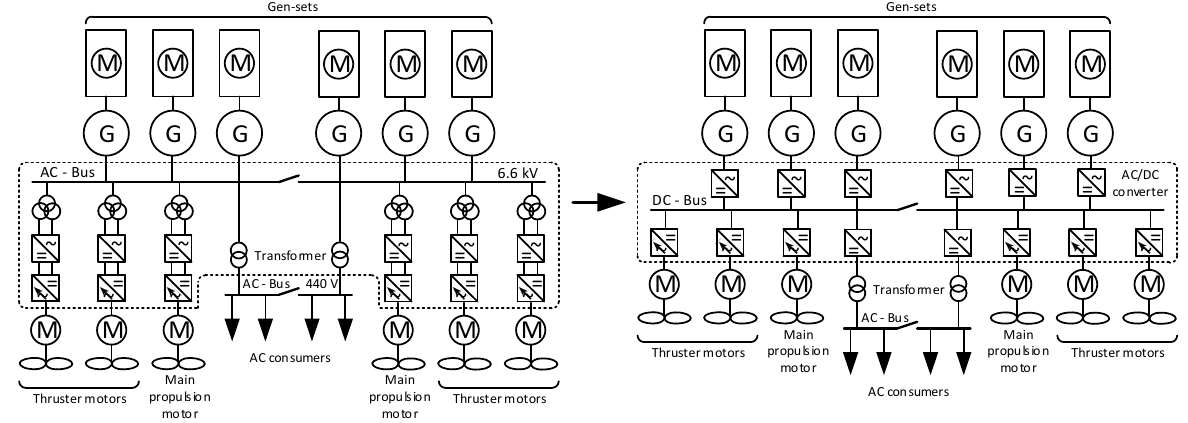
Figure 1. Comparison between the conventional AC grid and proposed DC grid of a pipe-layer ship [3,4].